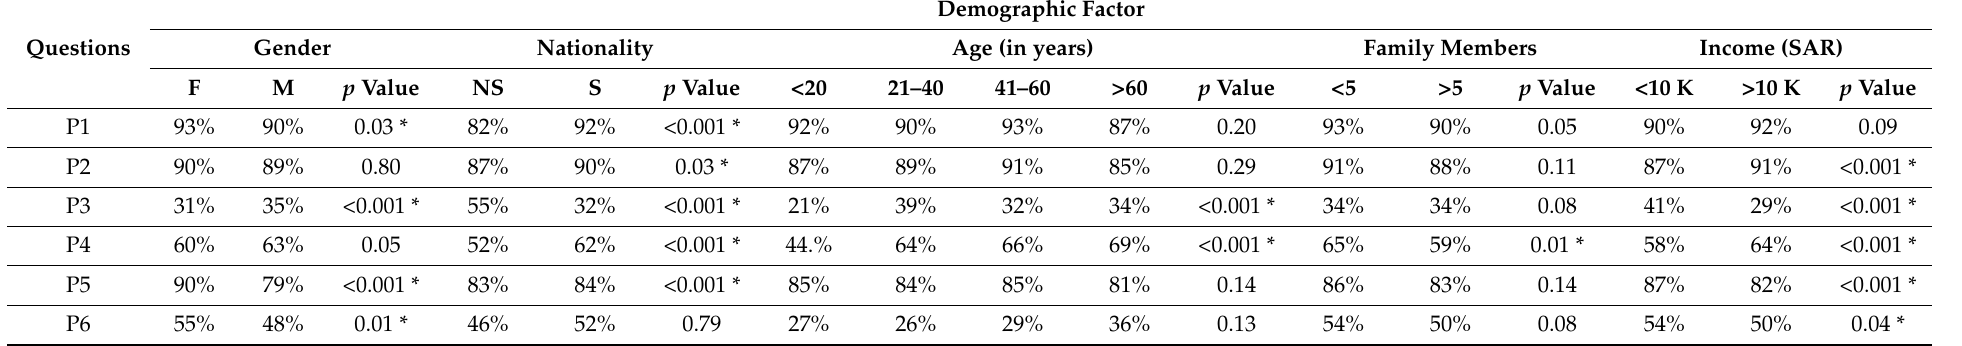
Table 3. Comparison of the effect of demographic factors on perception score during covid-19 in Arabian population.